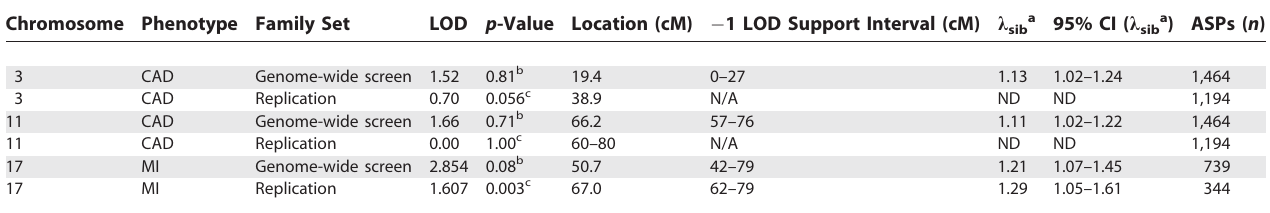
Table 2. Peak LODs on Chromosomes 3 and 11 (CAD Phenotype) and 17 (MI Phenotype) Chromosome Phenotype Family Set